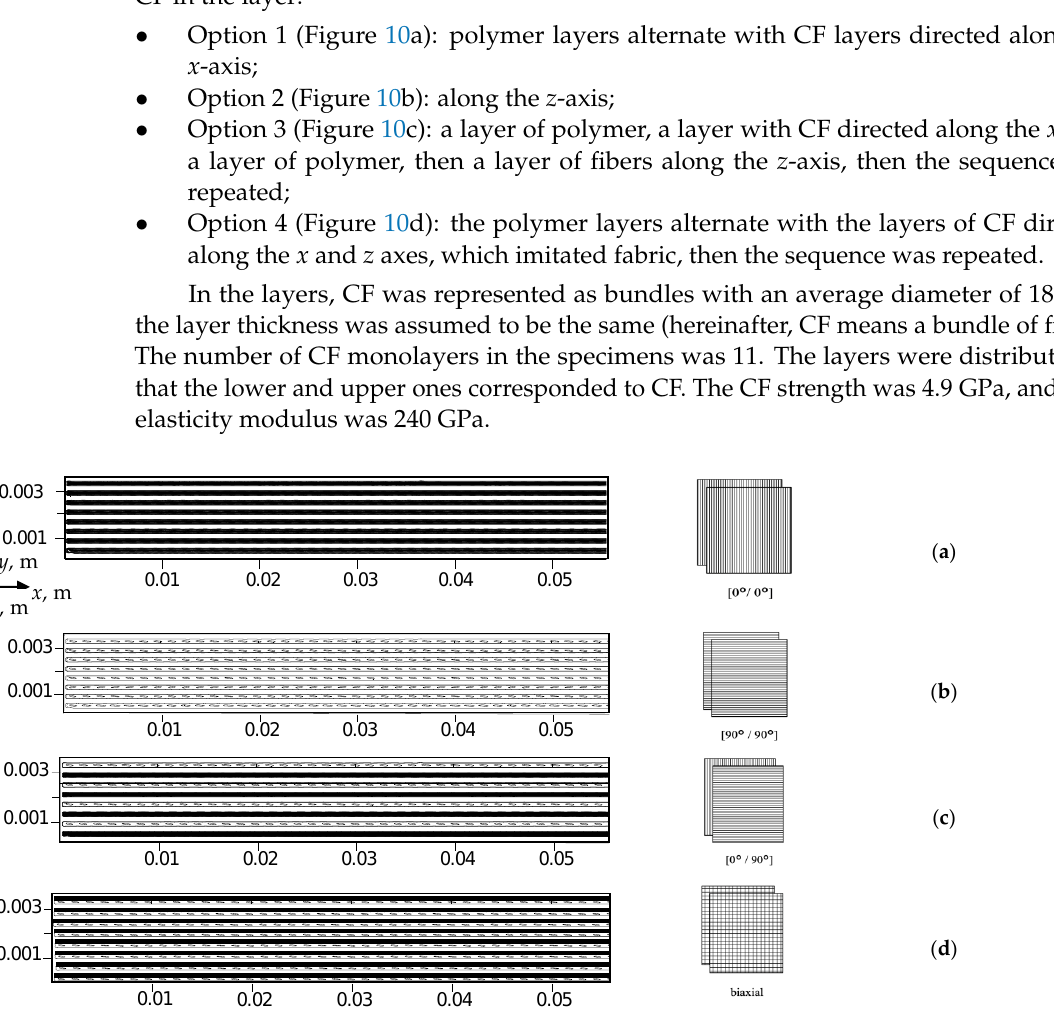
( c ) Figure 11. The schemes of composite-impregnated CF layers under tension: ( a ) along CF; ( b ) across CF; ( c ) shear along CF. According to the first part of the paper, the CF content in one direction was 80 vol.%. Therefore, the CF/polymer ratio was taken 20/80 vol. % in one layer for the unidirectional fabric, but 40/60 vol. % for the biaxial one, since its surface density was 2.2 times less than in the first case. Thus, the free space between CF was 20% in a monolayer, and 40% in a fabric one. This space could be filled with polymer, which was taken into account when calculating the properties of one layer. The computational domain size was 3.5  3.5 mm. The non-linearity of the PEEK and PI tensile diagrams was also considered (Figure 12). For CF, the elastic strain condition was preset.